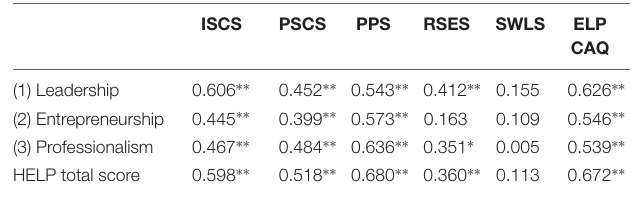
TABLE 3 | Summary of the correlation between the two parts of the ACS and ISC, PSC, F, IOS, PSR,